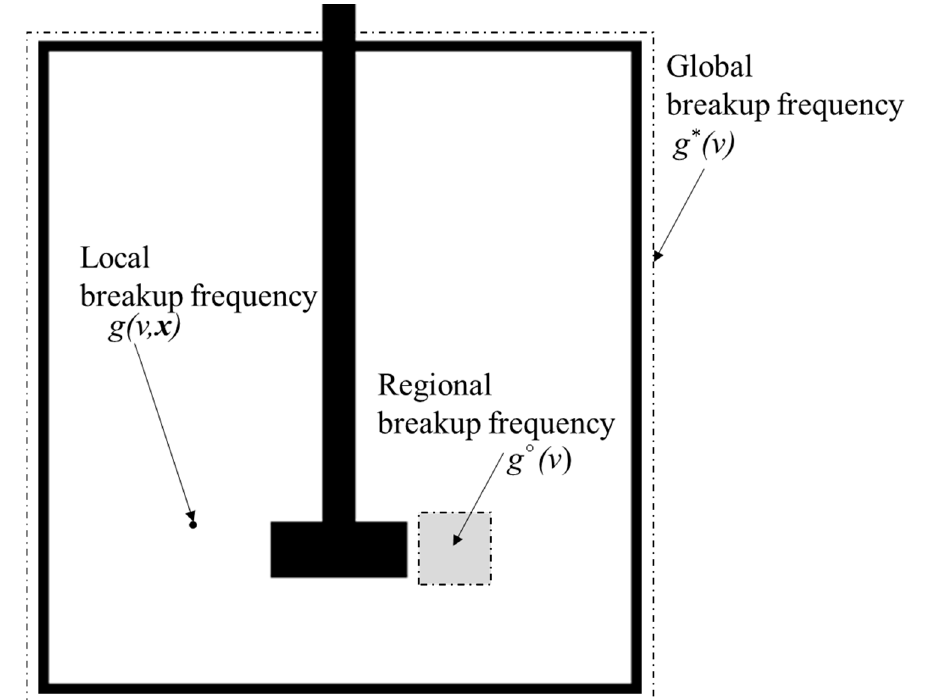
Figure 1. Illustration of the di ff erence between local, regional, and global breakup frequencies in the practical case of a stirred